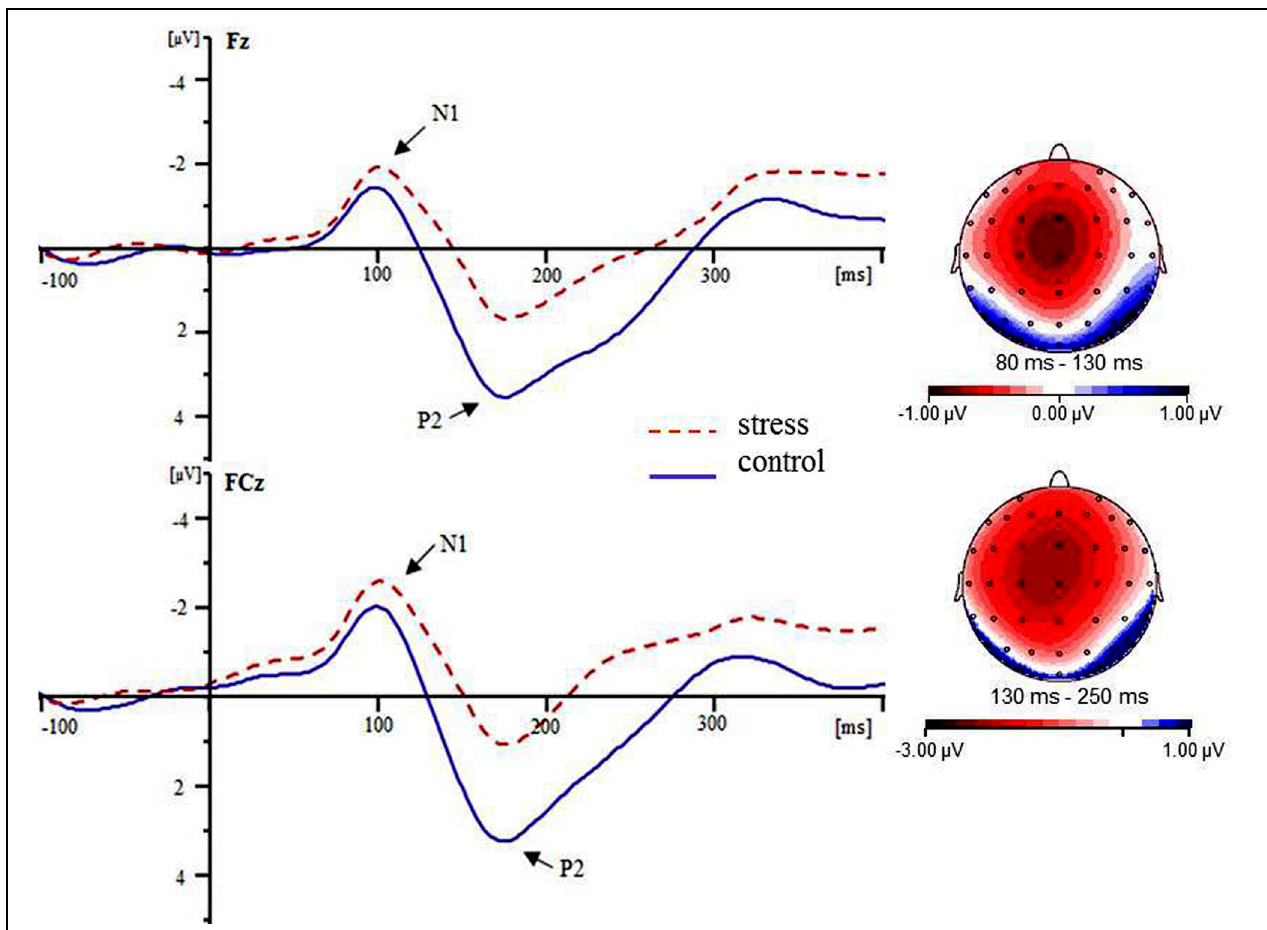
FIGURE 3 | Grand averaged ERPs for the stress condition (red dotted lines) and the control condition (blue solid lines) at the Fz and FCz electrode sites. The topographic maps indicate the distribution of the condition type effect during the N1 (80–130 ms) and P2 (130–250 ms) time